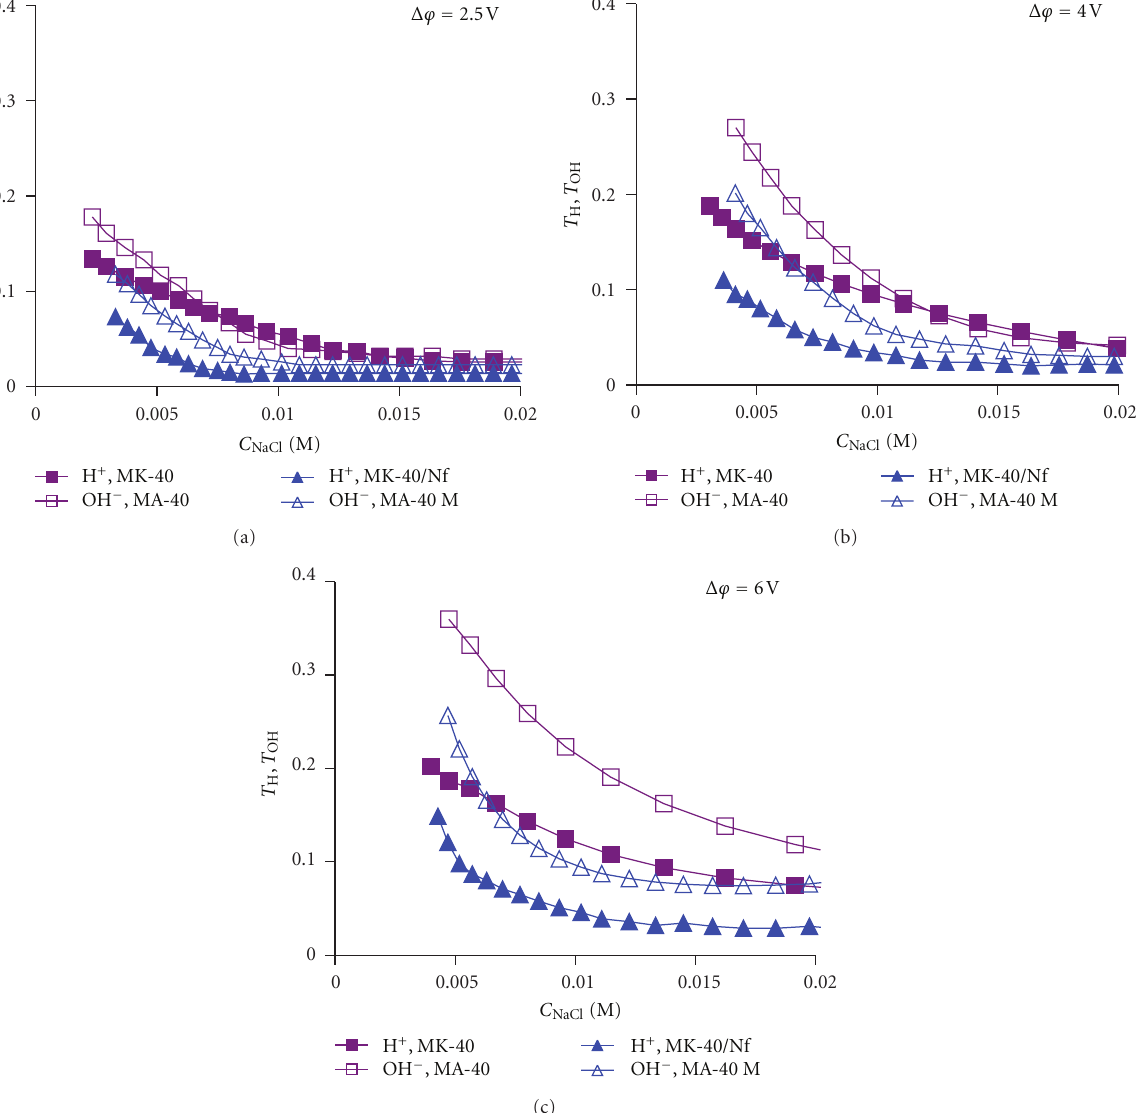
Figure 4: Concentration dependence of e ff ective transport number of protons in cation-exchange membrane and that of hydroxyl ions in anion-exchange membranes forming MK-40//MA-40 and MK-40/Nf//MA-40M desalination channels at potential drops ( Δ ϕ ) 2.5V (a), 4.0V (b), and 6.0 V (c) per cell